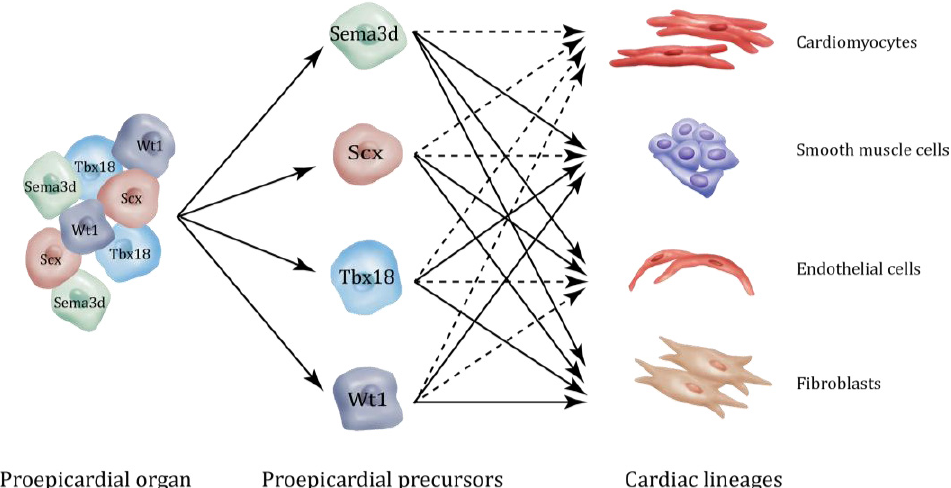
Figure 2. Heterogeneous proepicardial precursors and their fates. Distinct proepicardial sub-compartments variably give rise to coronary endothelial cells, vascular smooth muscle cells, fibroblasts and perhaps cardiomyocytes. Arrows represent differentiation potential. Dotted arrows indicate unresolved